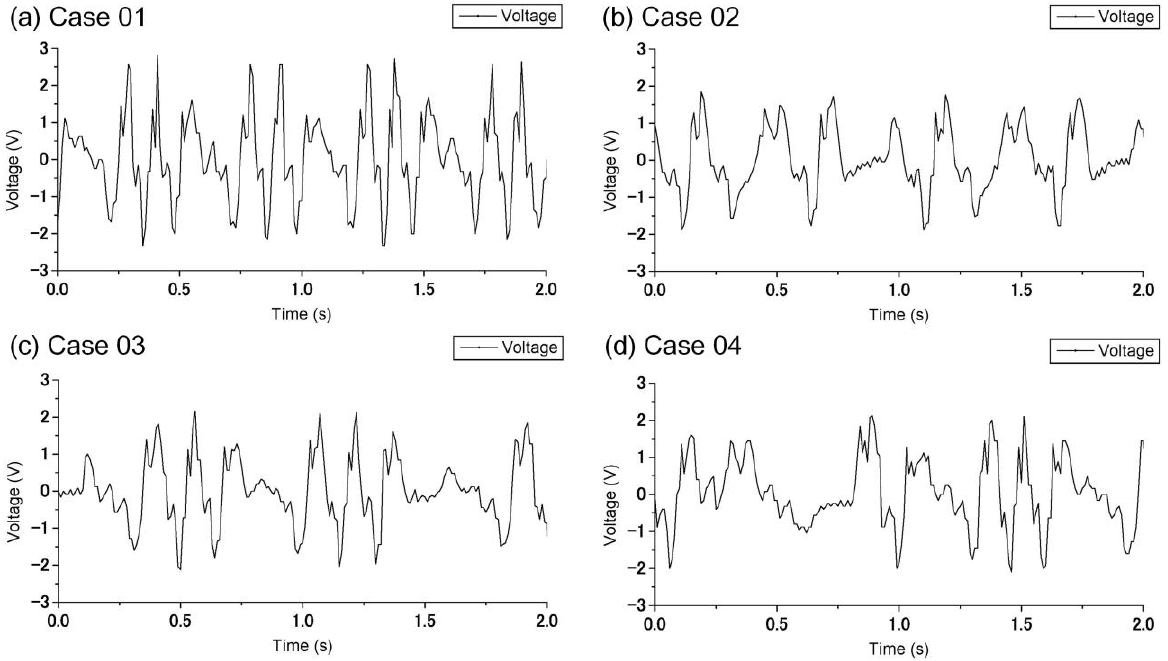
Figure 9. The measured voltage output of the PWEC in each case. Table 3. Electrical output in each case.